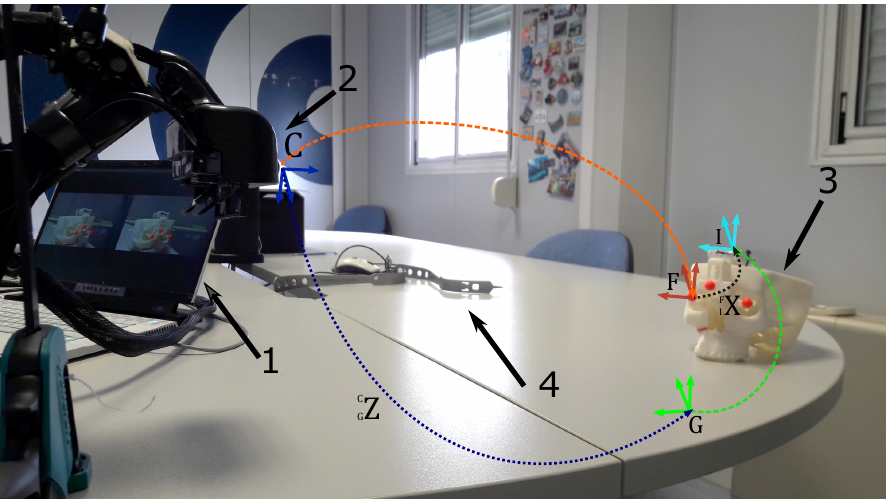
Figure 3. Experimental setup for the calibration procedure and the experimental session. 1 → External laptop running the augmented reality (AR) application with the side-by-side augmented camera frames. 2 → The custom-made see-through head-mounted display (HMD) capable of providing both video and optical see-through-based augmentations. 3 → The 3D-printed replica of a human skull comprising the IMU and the optical frame. 4 → Non-controllable and noisy lighting conditions.